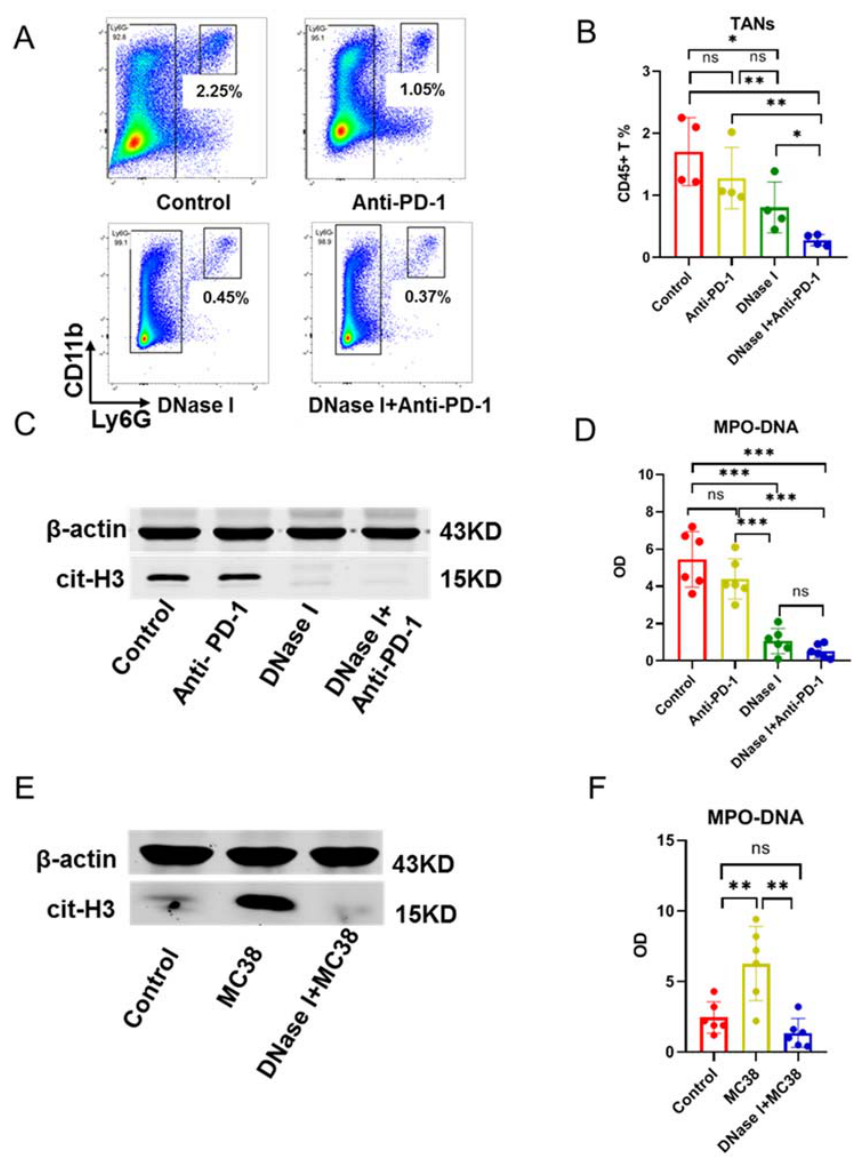
Figure 2. DNase I inhibits MC38 tumor cell ‐ induced TANs to form NETs in tumors. ( A , B ) Percentage of TANs within the tumor from mice with different treatments; n = 4 mice/group. ( C ) The cit-H3 protein levels in the tumor from mice with different treatments; n = 6 mice/group. ( D ) MPO-DNA levels in the serum from mice with different treatments; n = 6 mice/group. ( E ) The cit-H3 protein levels in the neutrophils with different stimulations; n = 6 mice/group. ( F ) MPO-DNA levels in the medium of neutrophils with different stimulations; n = 6 mice/group. The graphs show the means ± SD ( B , D ). ANOVA was performed with adjustment for multiple comparisons for ( B , D , F ). Note: * p < 0.05, ** p < 0.01, *** p < 0.001; NS: not significant. All statistical tests used in this figure were two-sided and p < 0.05 was considered statistically